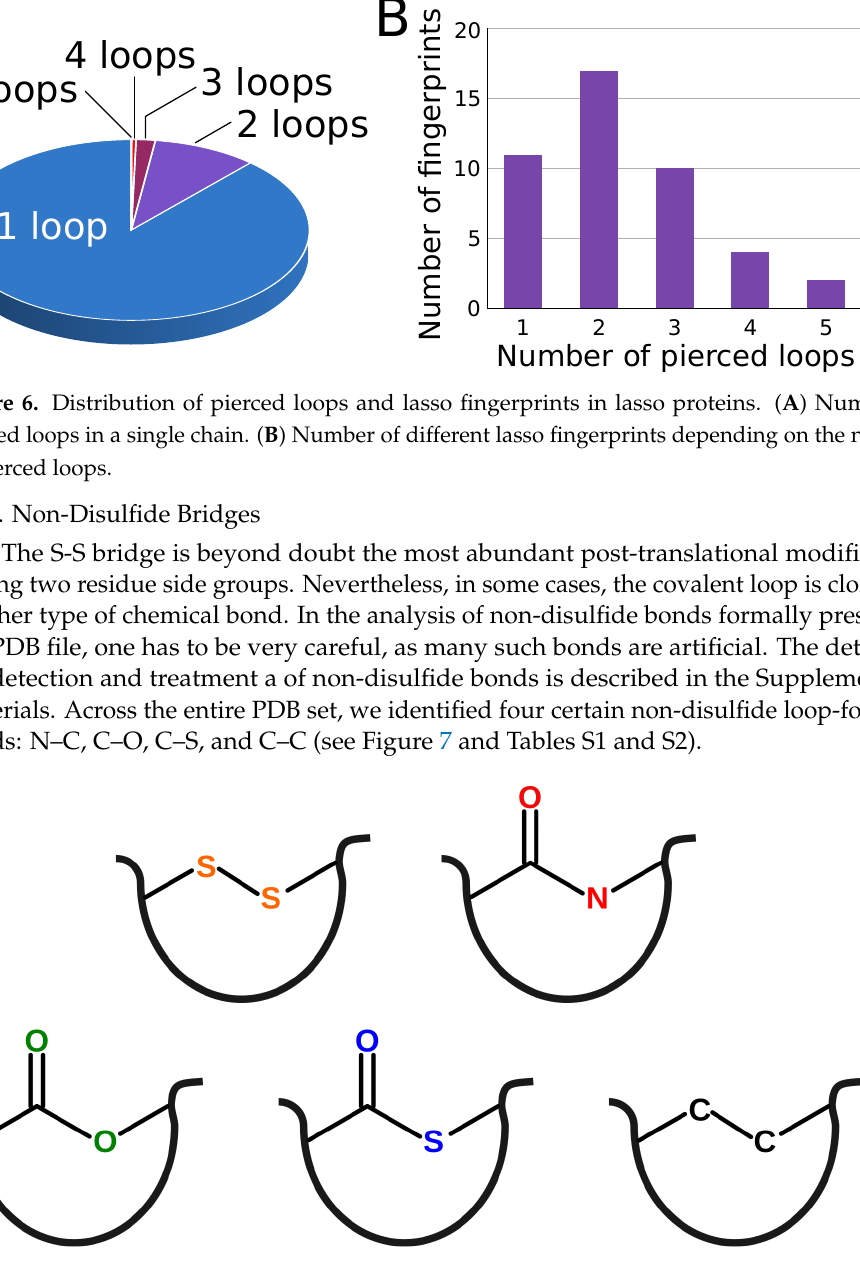
Figure 7. Loop-forming bonds found in PDB. From left to right, ( top row) disulfide, amide ( bottom row) ester, thioester, C–C. The amine, ether, and thioether bonds lack the keto-oxygen atom. The black curve denotes the protein